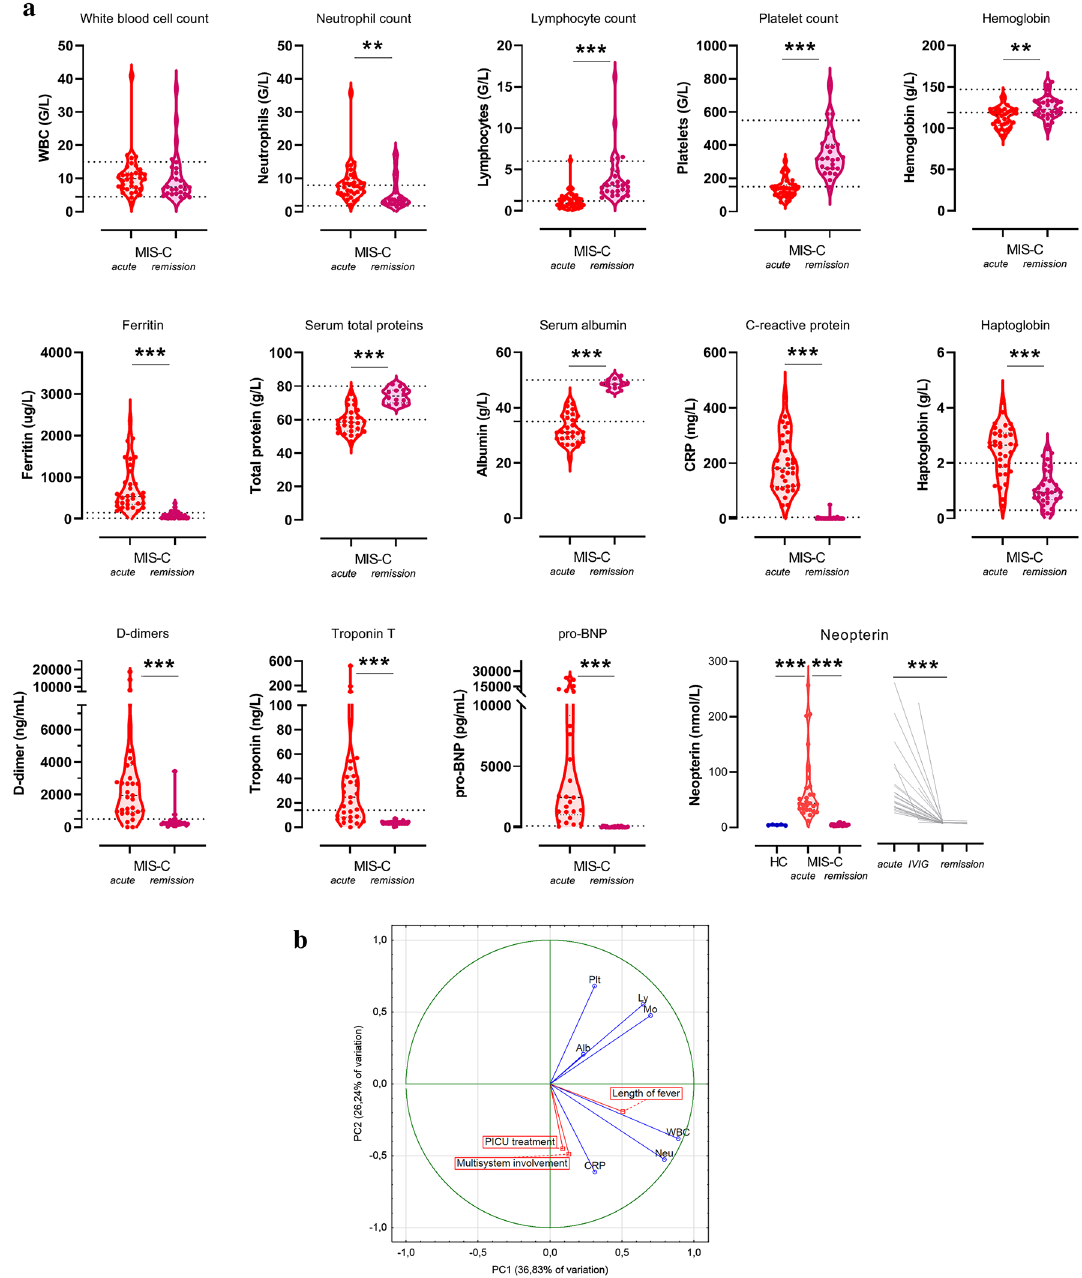
Figure 2. Disease severity marker levels before and after IVIG therapy in the MIS-C cohort. ( a ): Pre- and > 10 days post-IVIG treatment (denoted acute and remission ) absolute blood counts and clinical laboratory results of the 34 MIS-C cases. The horizontal lines indicate the age-specific reference ranges. Since no established reference range was available for neopterin, results of healthy controls are shown for this marker, together with individual changes of levels during IVIG treatment and in remission. P value symbols (** p < 0.01, *** p < 0.001) indicate significant results after 5% false discovery rate correction using the Benjamini–Hochberg method. ( b ): Principal component analysis loading plot of the top 7 features contributing to principal components one and two. Loading of length of fever, PICU treatment and extent of multisystem involvement (indicated by boxes) are shown as supplementary variables. ( c ) : Heatmap of correlation matrix of clinical and laboratory markers of MIS-C. Clinical score indicates the total number of organ systems involved, including skin (rash, feet and hands signs), mucosal (conjunctivitis, cheilits, oral mucositis), gastrointestinal (diarrhea, vomiting, abdominal pain) and cardiac involvement. Color-coding indicates the strength of each correlation (Spearman correlation coefficients) with asterisks indicating significance (* indicate p < 0.003 significant results, the limit was obtained after 5% false discovery rate correction using the Benjamini–Hochberg method). Non-significant differences are not